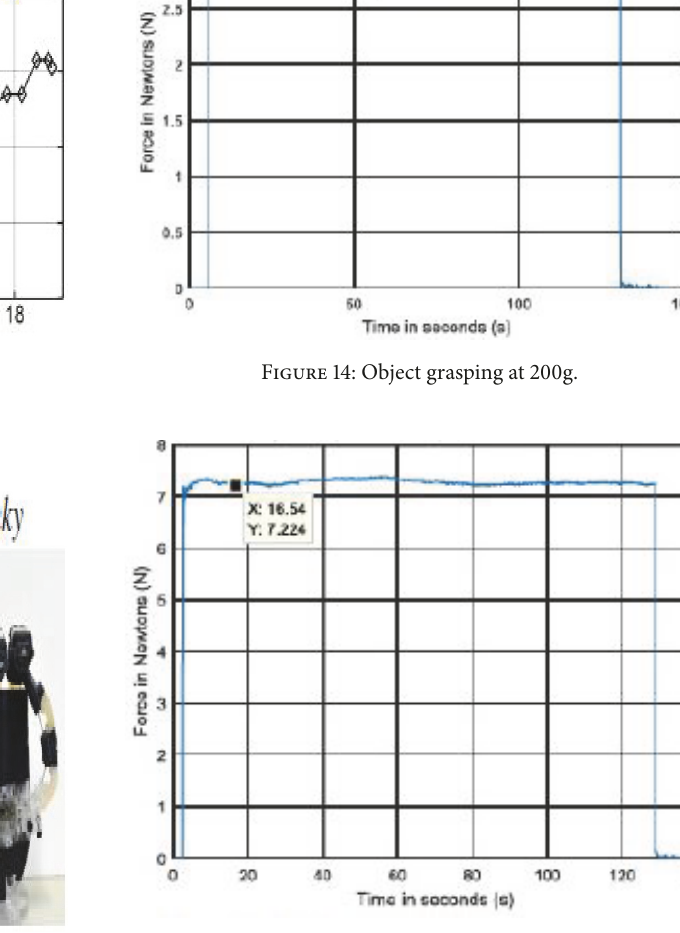
Figure 15: Object grasping at